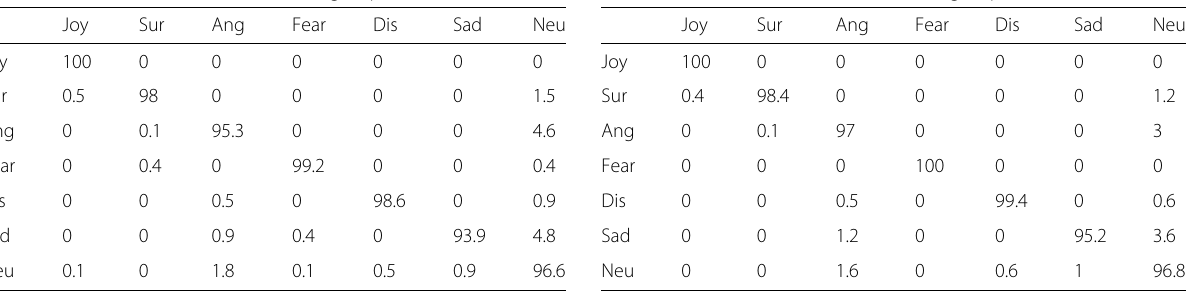
Table 4 Confusion matrix (%) of cross-validation testing method for 7-class emotion in CK+ dataset using Improved GLTP